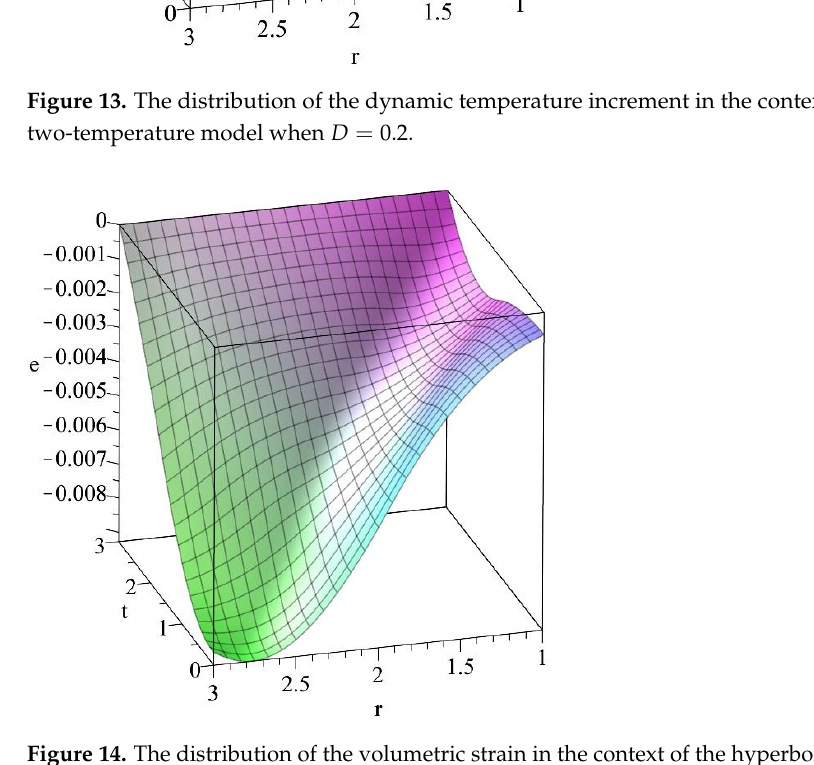
Figure 14. The distribution of the volumetric strain in the context of the hyperbolic two-temperature model when D = 0.2 .